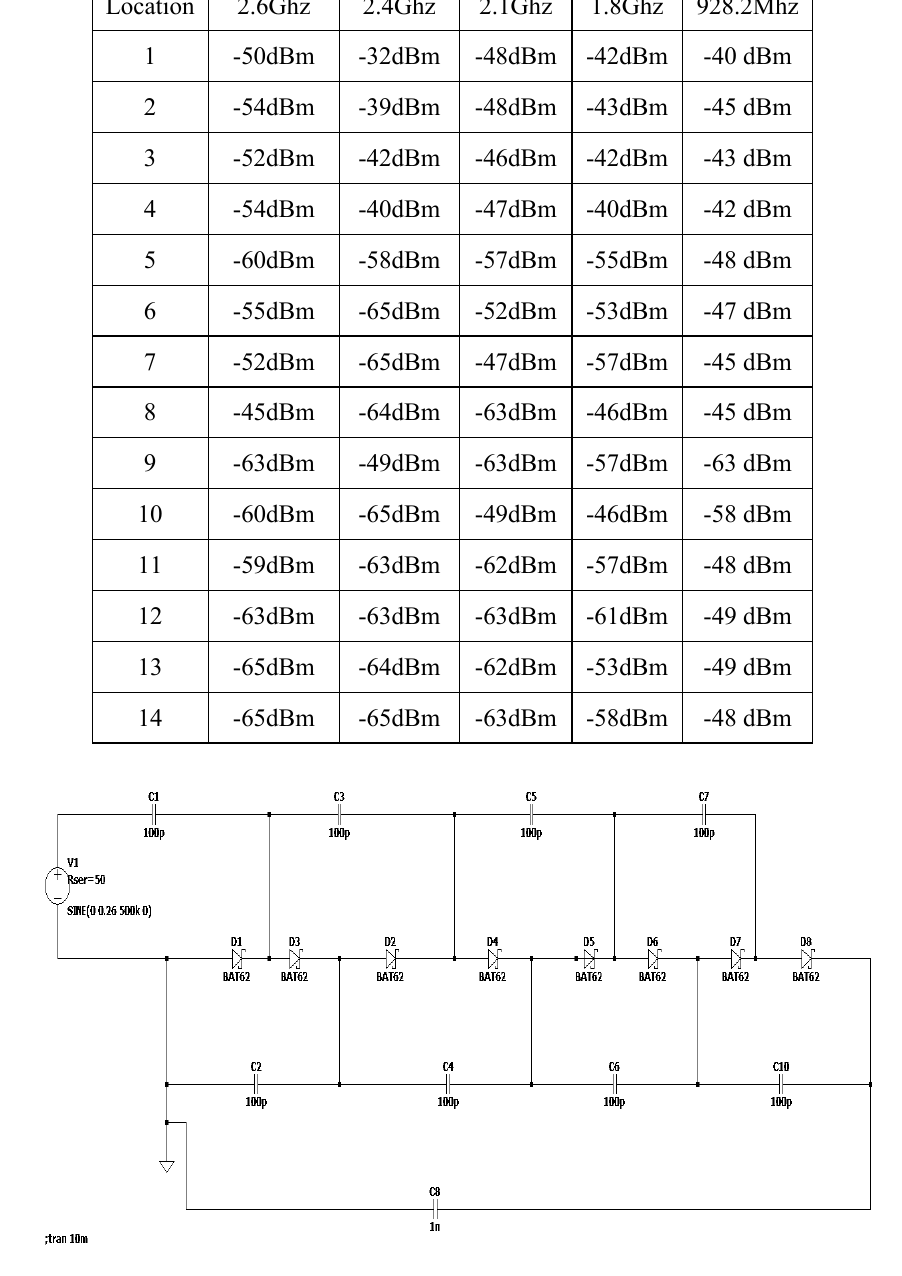
Fig. 1. Test circuit model in